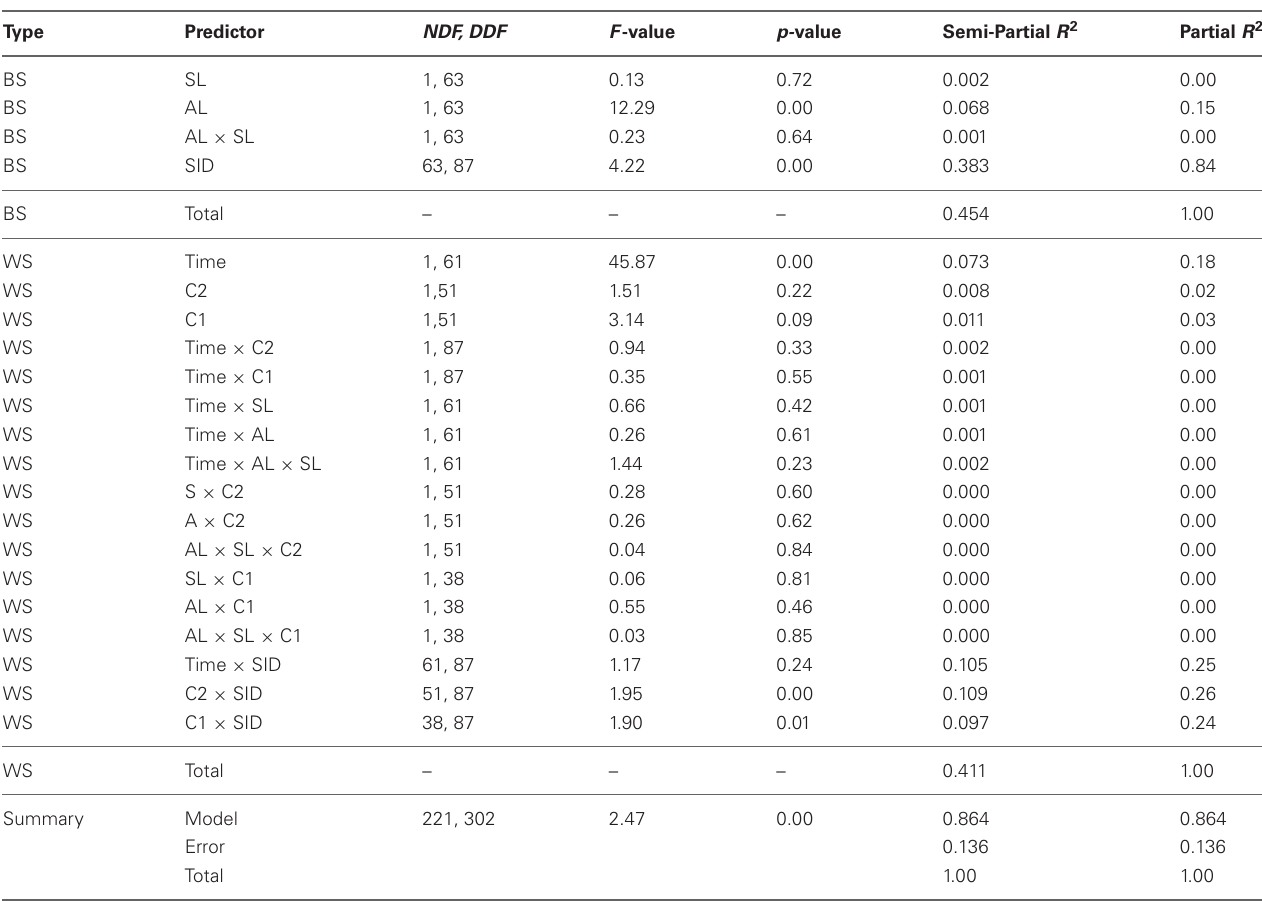
Table 9 | Hypothesis tests and effect sizes for between-subjects and within-subjects